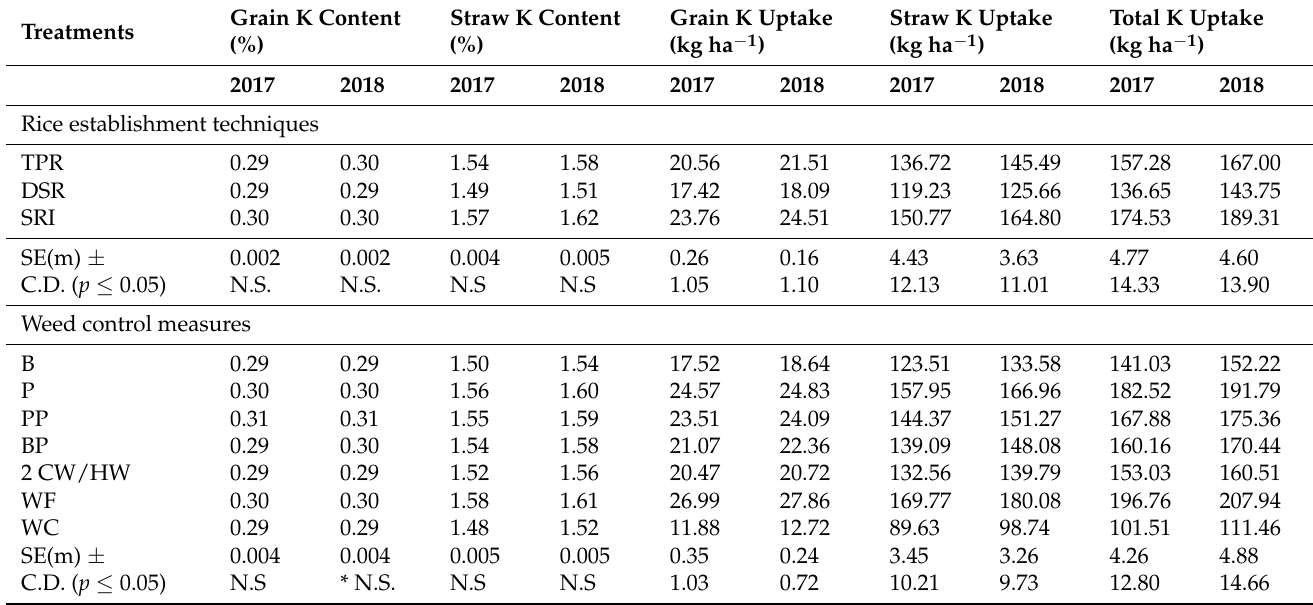
Table 6. Influence of rice establishment techniques and weed control measures on potassium content (%) and uptake (kg ha − 1 ) of rice.